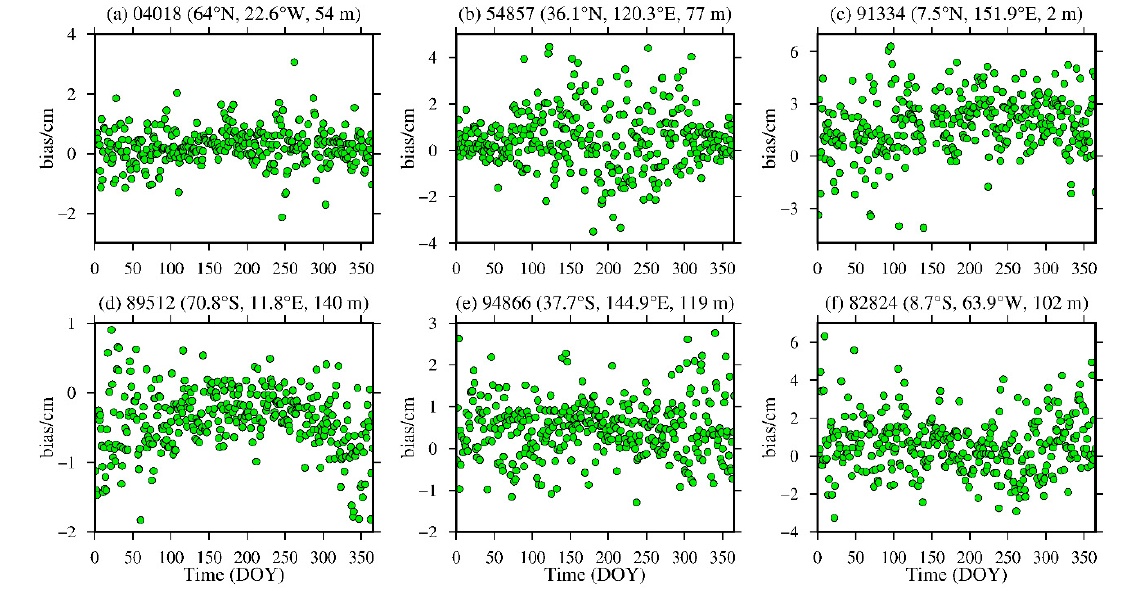
Figure 10. ZWD bias time series of stations ( a ) 04018, ( b ) 54857, ( c ) 91334, ( d ) 89512, ( e ) 94866 and ( f ) 82824 derived from the MERRA-2 data from 2015 (the content in parentheses indicates the latitude, longitude and altitude of the radiosonde station). Table 4. Descriptive statistics of the daily average bias and RMS of the ZWD and ZTD values of six representative radiosonde stations from 2015. ZWD